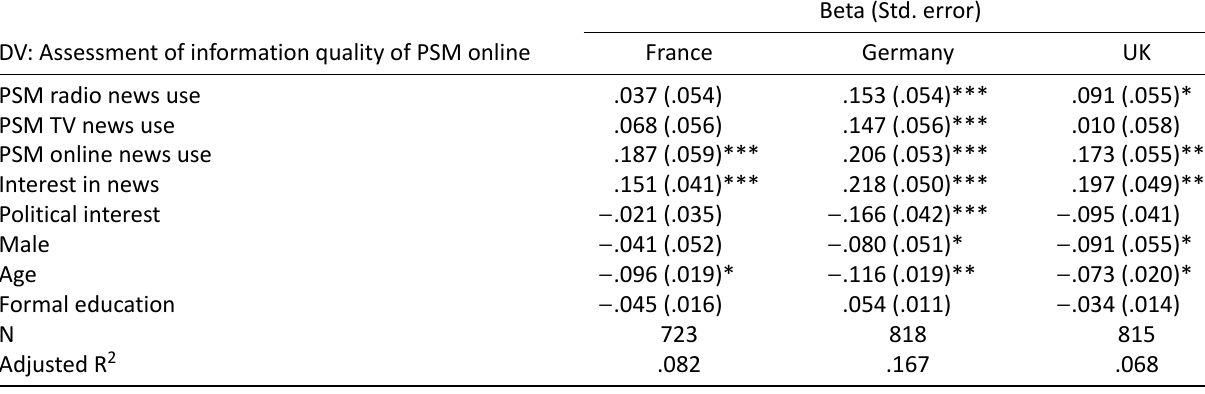
Table 6. Effects on the assessment of information quality of PSM online in France, Germany, and the UK (multiple linear